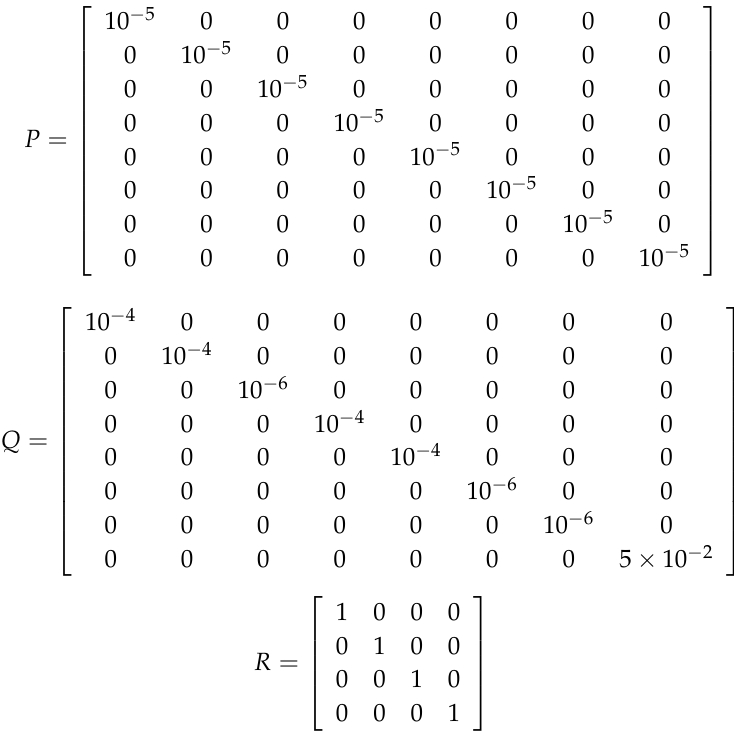
Figure 7. The estimated value of load torque. The RLS algorithm is used for identifying the parameters of the energy model, and the results of identification are shown in Figure 8. We can see that the identified values achieve a steady value after approximately 50,000 times recursion, and the identified values of the parameters are obtained. Table 2 shows the comparison between the identified values and the true values. The identification error is less than 4%, and it can be seen that the identified results are acceptable when motor speed and load torque cannot be obtained directly. In the simulation process, the results of the parameter identification based on RLS are influenced by the accuracy of the estimated motor speed and load torque. In addition, the accuracy of the estimated motor speed is greatly influenced by the set values of the EKF algorithm.